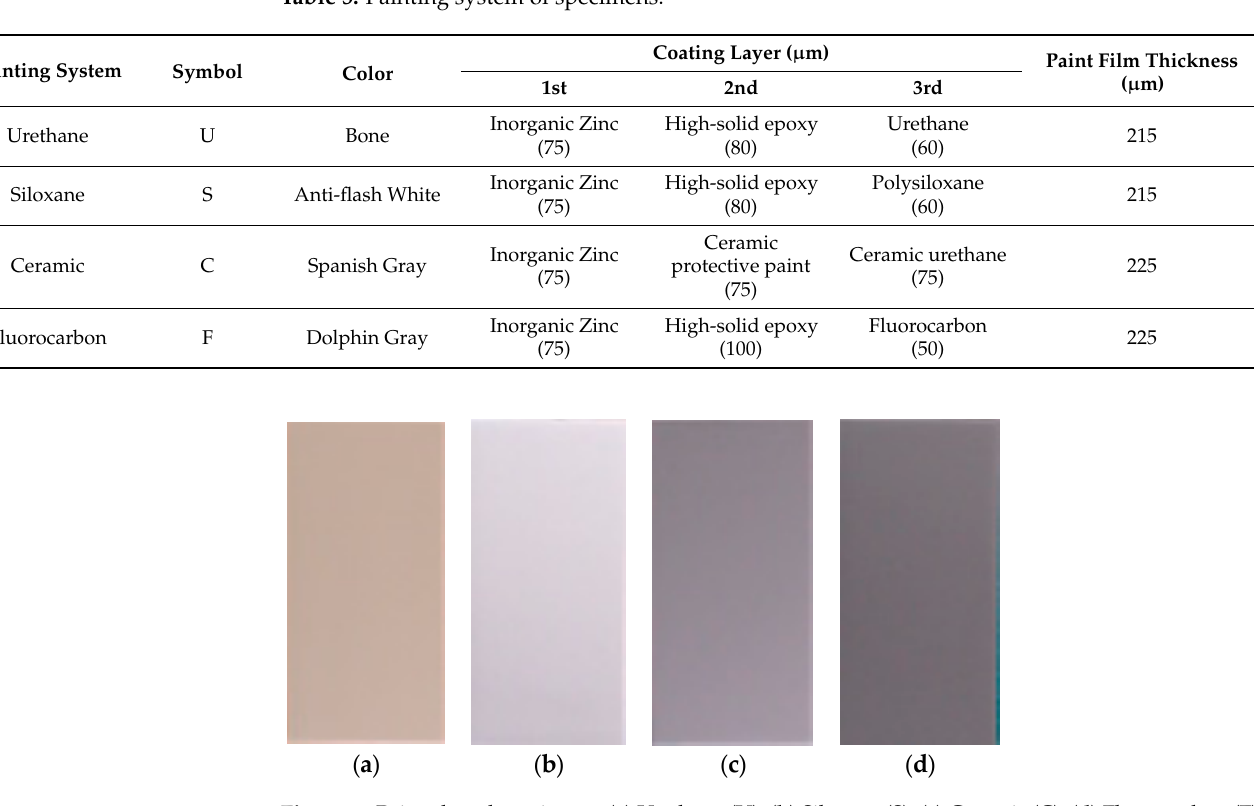
Table 5. Painting system of specimens.